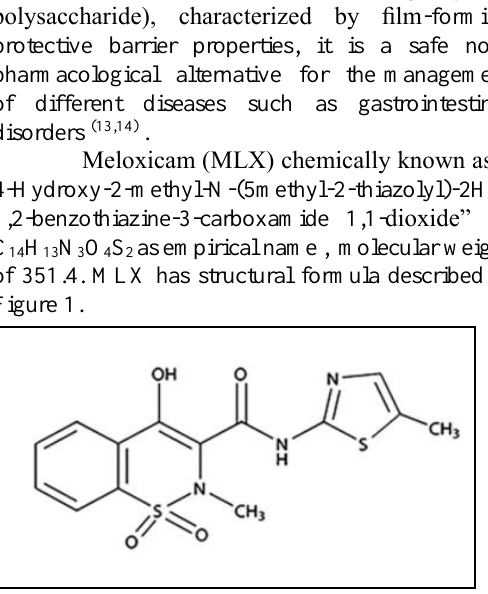
Figure 1.Structural formula of MLX